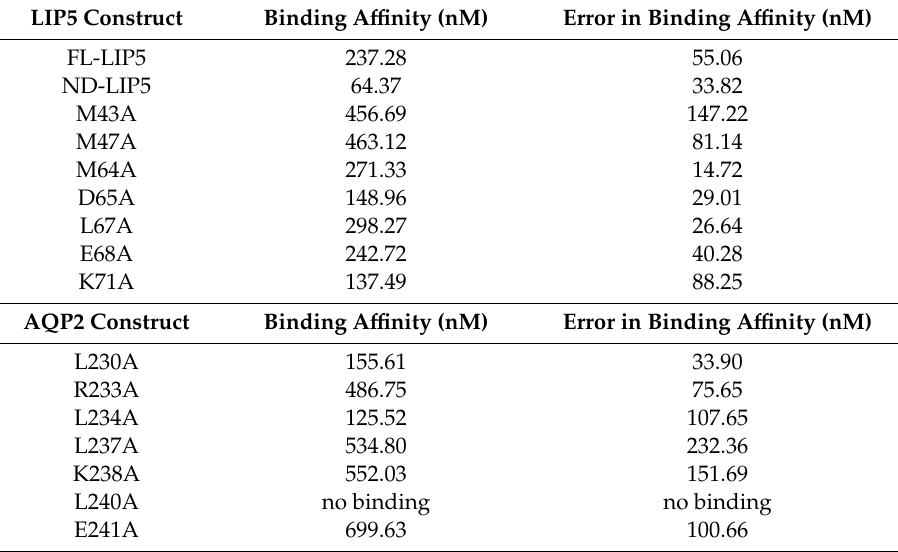
Table 2. Binding a ffi nities of the AQP2 and LIP5